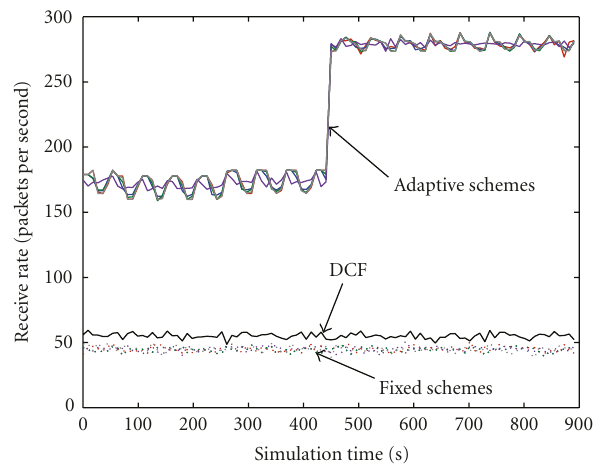
Figure 18: Receive rates for scenario